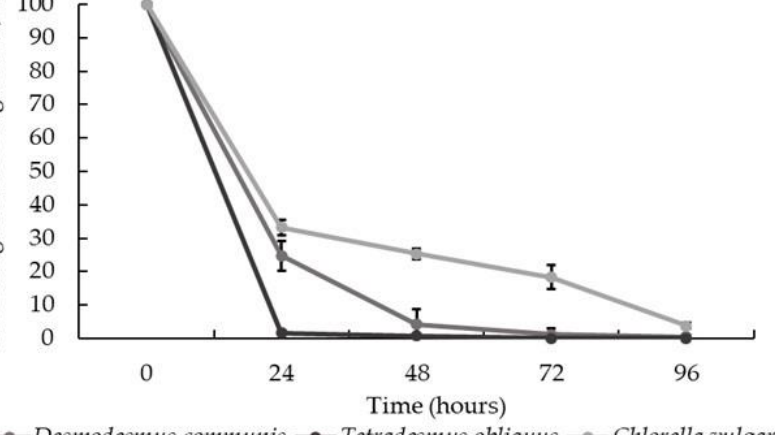
Figure 3. Percentage of selected microalgae remaining in suspension when bio-flocculated with I. lacteus against the treatment time. Standard deviation represents the average from three replicates.